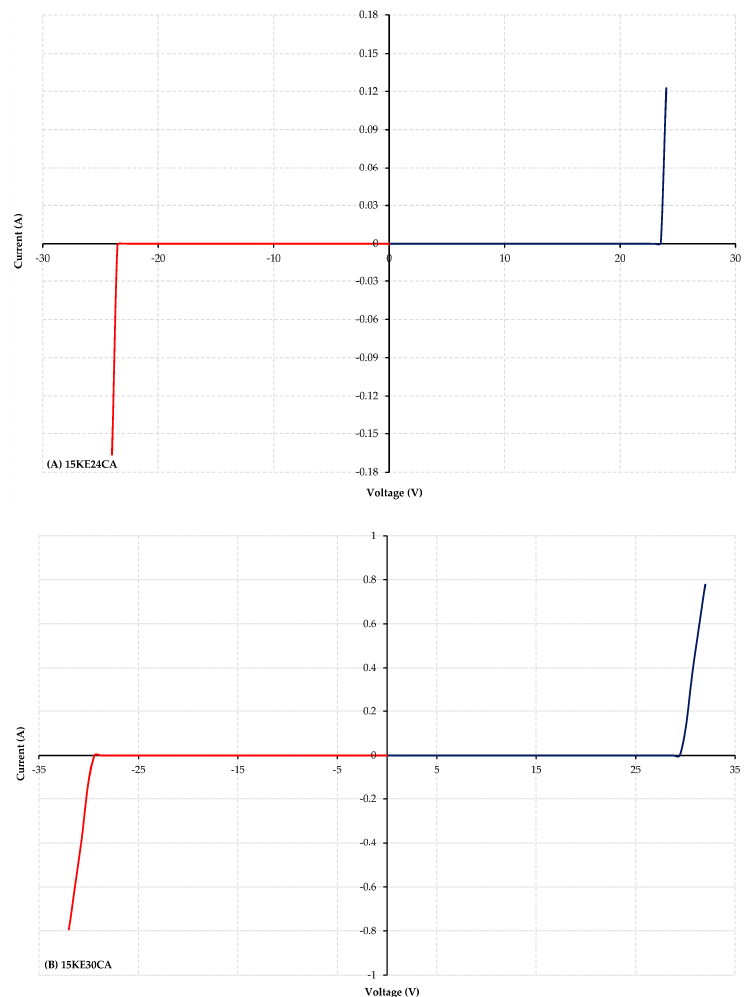
Appl. Sci. 2020 , 10 , x FOR PEER REVIEW Figure 3. I–V characteristic curve for ( A ) 1.5KE24CA and ( B ) 1.5KE30CA Zener diode.